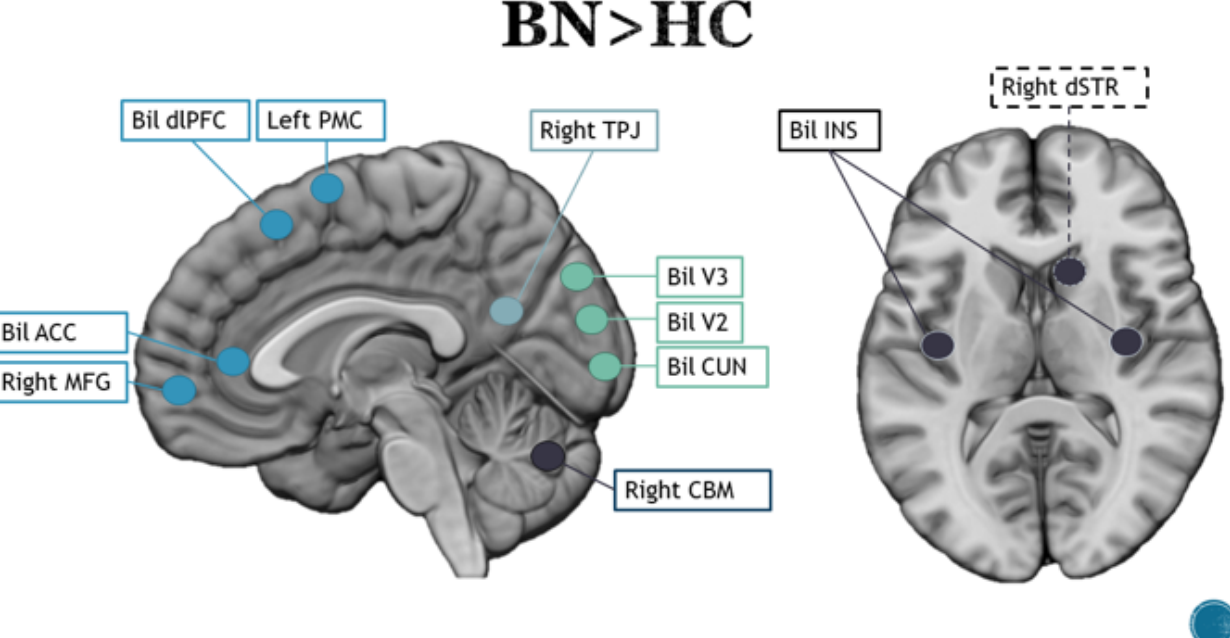
Figure 3. Main brain areas observed in the contrast between bulimic patients and healthy controls. Blue lines represent frontal areas, light blue represent parietal areas, green lines represent occipital areas and black lines represent subcortical regions and the cerebellum. Dotted lines represent mesial regions, whereas solid lines represent lateral and superficial areas.